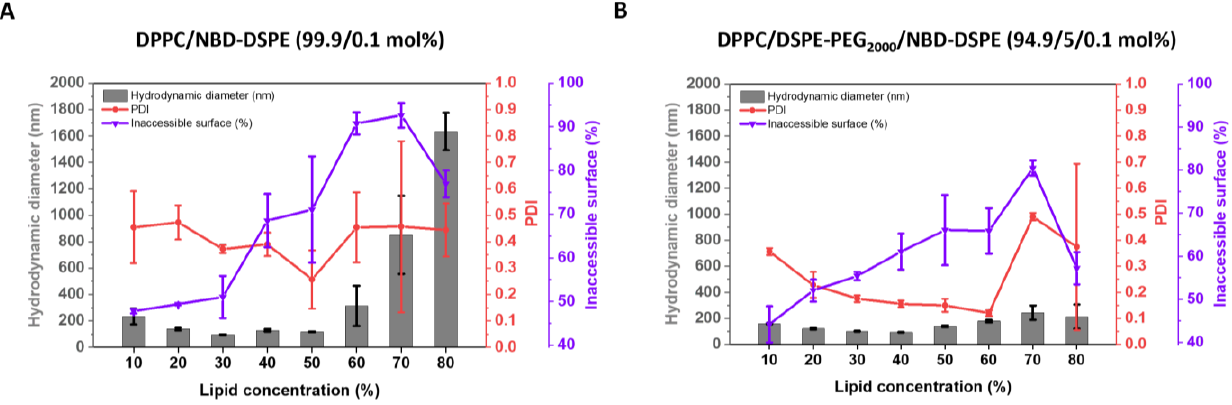
Figure 6. IAS-determination of cholesterol-free liposomes. ( A , B ): IAS-assay and DLS results of DPPC/ NBD-DSPE 99.9/0.1 (mol%) ( A ) and DPPC/DSPE-PEG2000/NBD-DSPE 94.9/5/0.1 (mol%) ( B ) of DC prepared liposomes (2350 rpm, 40 °C, and 30 min) dependent on the lipid concentration (10–80%) used for the DC-homogenization of the lipid/buffer mixture. The resulting VPGs were redispersed with TRIS buffer at 1500 rpm, for 2 min, and at 20 °C. The liposomes were prepared and diluted in TRIS buffer containing 25 mM NaCl. To quench the accessible surface, sodium dithionite was added (10 mM) to liposomes diluted in a buffer (0.05 mM lipid). Data are shown as the mean ± SD (n = 3).